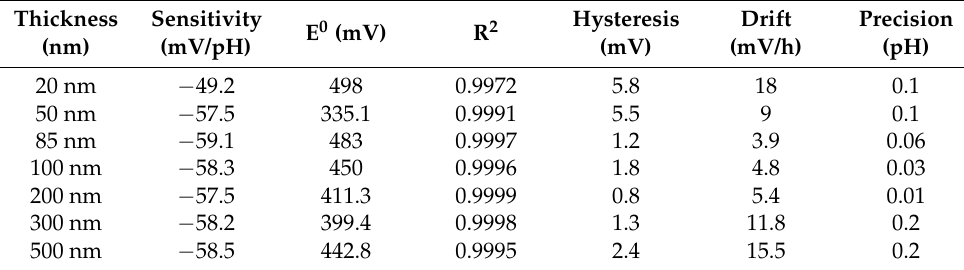
Table 5. Summary of 25 to 500 nm TiN electrode in the 2–12 pH range, equilibrated at pH